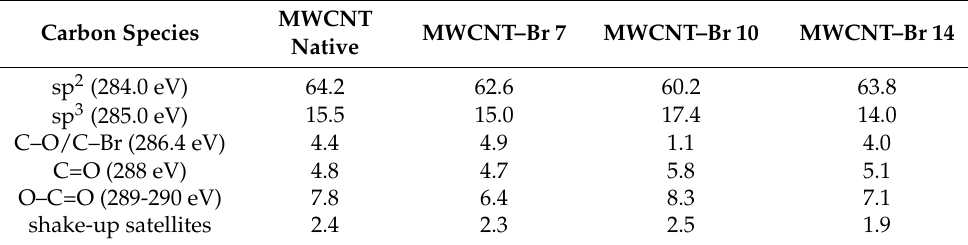
Table 3. Comparison of carbon species concentration data (at%) from C1s